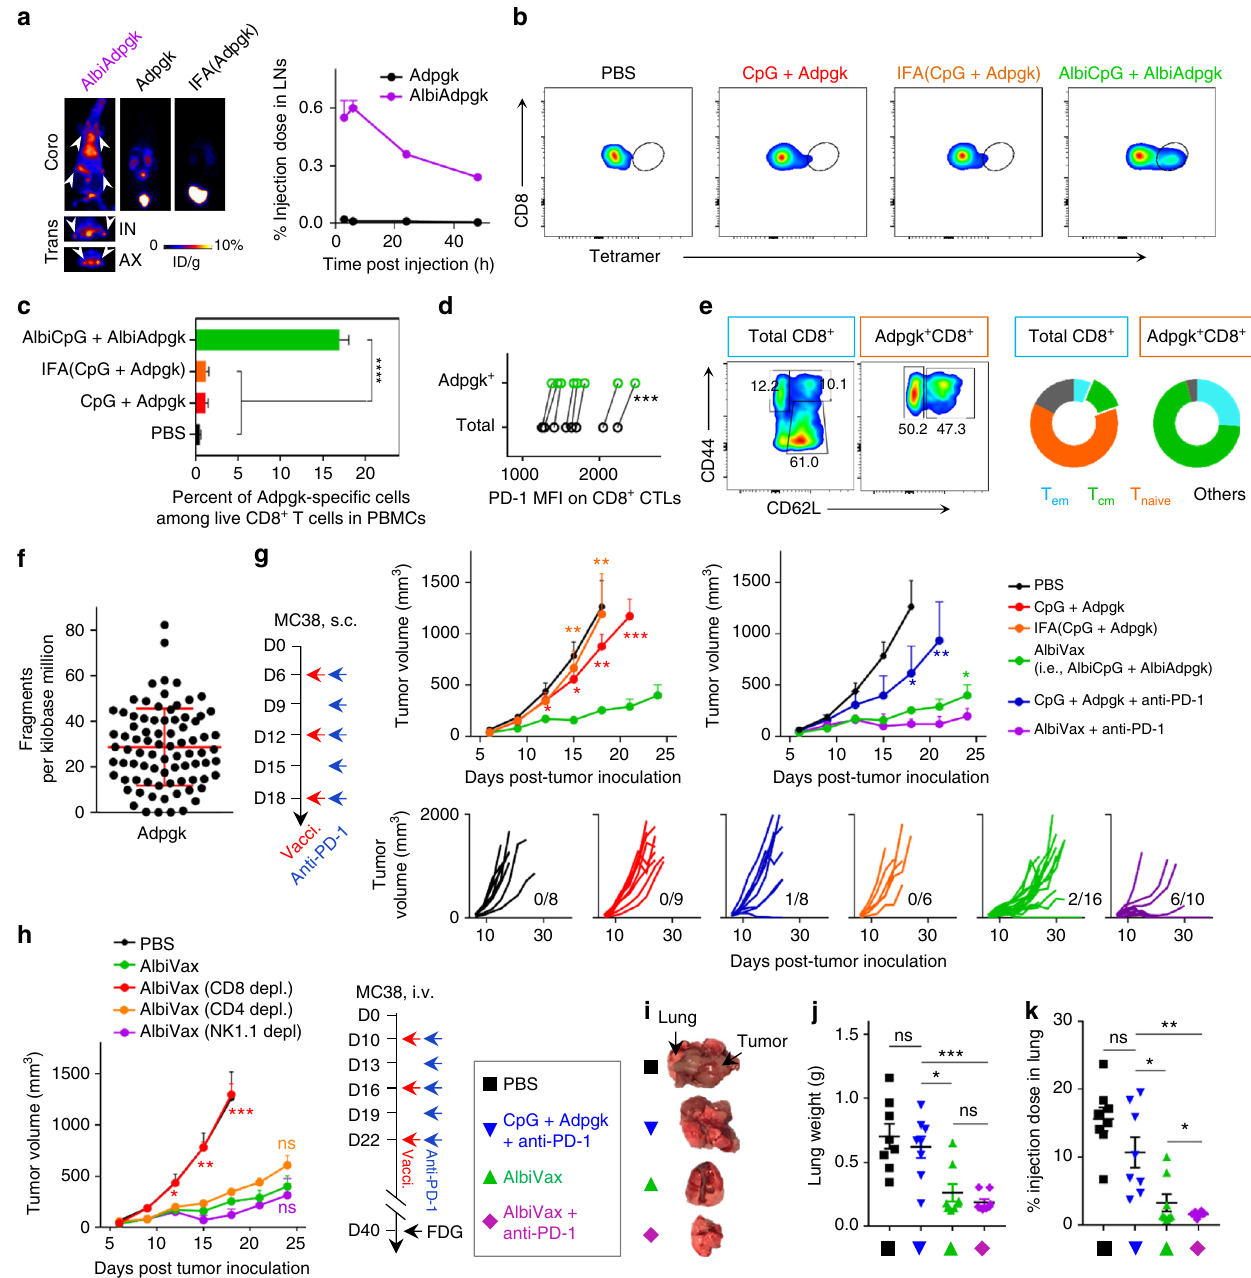
Fig. 6 Neoantigen-based albumin/AlbiVax nanocomplexes for personalized cancer immunotherapy. a Upper: representative coronal and transverse PET images at 6 h post injection, and lower: quanti fi cation of albumin/AlbiAdpgk nanocomplexes and Adpgk in IN and AX LNs of FVB mice ( n = 4). White arrows mark LNs. IFA(Adpgk) was undetectable in LNs. (Dose: 4.4 – 5.5 Mbq) b – e C57BL/6 mice ( n = 5) were vaccinated with AlbiVax (2 nmol AlbiCpG + 20 µ g AlbiAdpgk) on day 0 and day 14, followed by fl ow cytometric analysis of H-2D b -ASMTNMELM tetramer + CD8 + T cells ( b , c ) and PD-1 expression on peripheral CD8 + T cells ( d ) on day 21, and CD8 + T cell central memory (CD62L high CD44 + ) on day 50 ( e ). f Exome-sequencing results verifying Adpgk variant in MC38 cells. g , h MC38 tumor growth after treatment with AlbiVax alone or in combination with anti-PD-1. C57BL/6 mice were s.c. inoculated with 3 × 10 5 MC38 cells, treated with AlbiVax (2 nmol AlbiCpG + 20 µ g AlbiAdpgk) on day 6, day 12, and day 18), and with anti-PD-1 (200 µ g) every 3 days from day 6 for six times. h Depletion of CD8 + T cells, but not CD4 + T cells or NK cells abrogated the therapeutic ef fi cacy of AlbiVax ( n = 5). i – k Immunotherapy of lung metastatic MC38 tumor with AlbiVax alone or in combination with anti-PD-1. C57BL/6 mice were i.v. inoculated with 1 × 10 5 MC38 cells, treated with AlbiVax (2 nmol AlbiCpG + 20 µ g AlbiAdpgk) on day 10, day 16, and day 22), and with anti-PD-1 (200 µ g) every 3 days from day 10 for six times. On day 40, mice were injected with FDG tracer (100 µ Ci). Mice were killed and lungs and tumors were collected ( i ), weighted ( j ), and radioactivity measured by γ -counting ( k ). Data show mean ± s.e.m. of two – three independent experiments. *** p < 0.001, ** p < 0.01, * p < 0.05, ns: not signi fi cant ( p > 0.05) by one-way ANOVA with Bonferroni